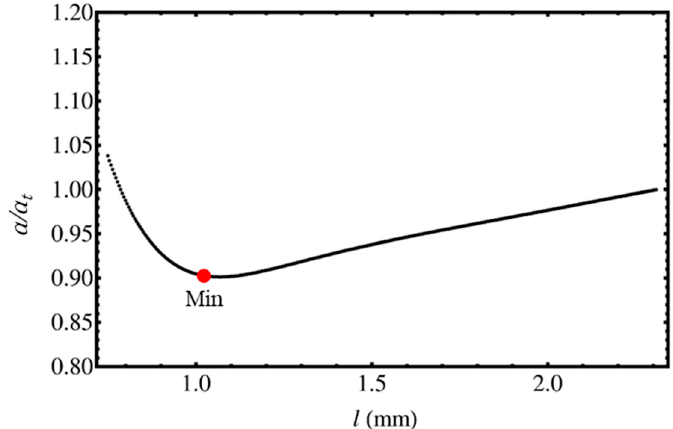
Figure 5. Change in the ratio of thermal diffusivity calculated from the phase lag at a thermal diffusion length with respect to the heating-detection distance.